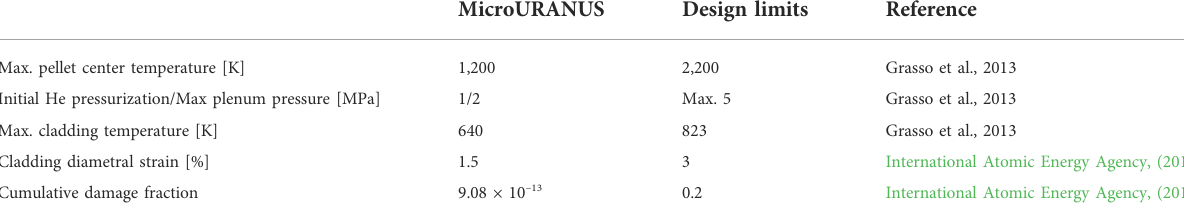
TABLE 5 Design limit analysis results of